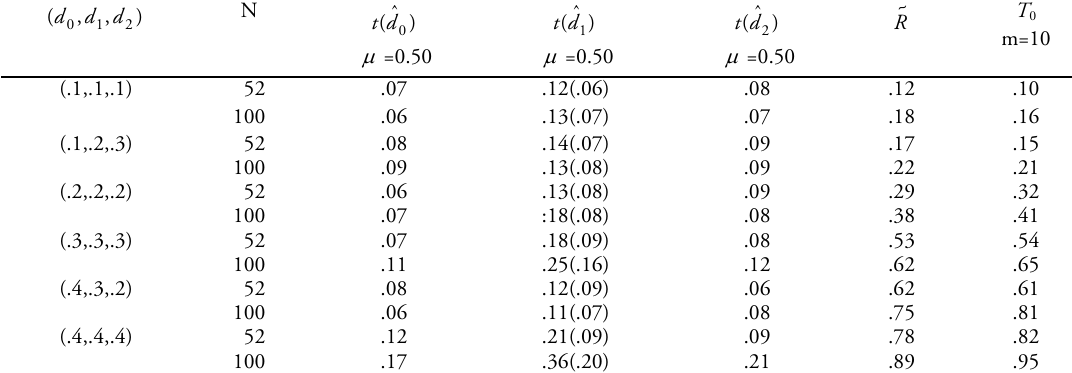
Estimated powers of the seasonal fractional integration tests for